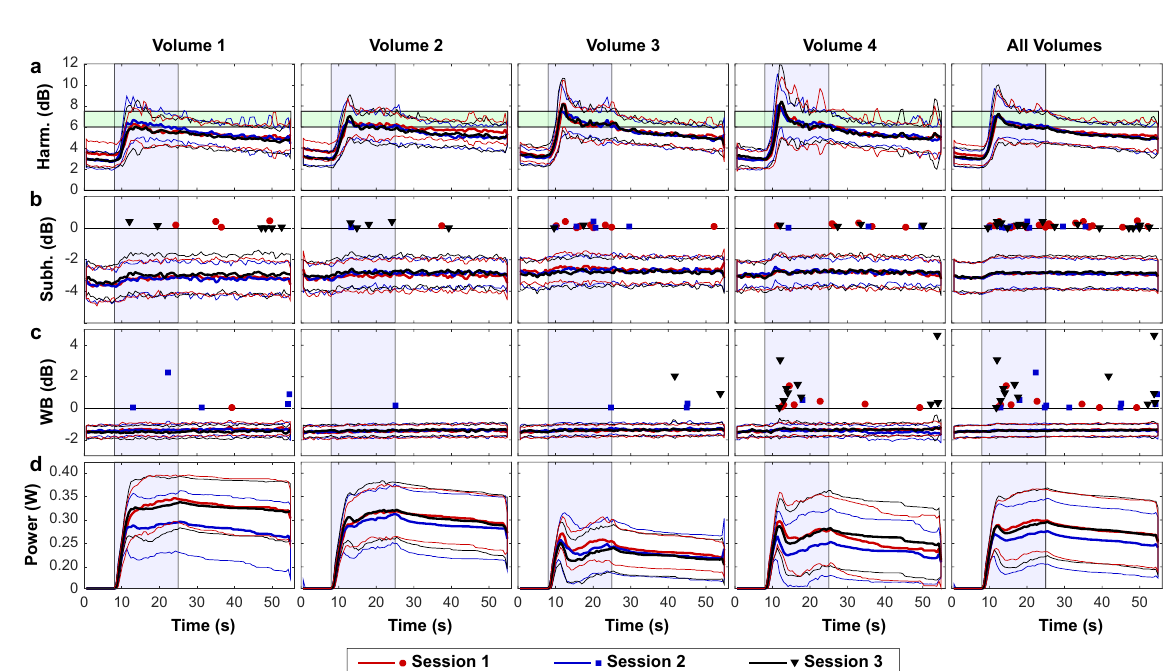
Figure 3. Mean acoustic emissions and acoustic power vs. time for all animals for the four volumetric sonications. ( b ) Harmonic emissions were the basis to control the power level at each target to achieve a pre- determined level between 6–7.5 dB above the noise floor. The controller began 8 seconds after the start of the sonication to allow time for the microbubbles to reach the brain; it was not allowed to increase the power after 25 seconds to avoid increasing the power as the microbubbles were cleared from circulation. Overall, the levels achieved were similar for the four locations targeted, for the three sessions, and for the different animals in the drug distribution study. Some overshoot was evident, particularly in locations 3 and 4. ( c ) Subharmonic emissions, plotted here in dB relative to the threshold used to trigger a reduction in acoustic power, were not reliably detected. The triggers that occurred are noted by the filled symbols and generally were only occurred at an amplitude slightly above this threshold. ( d ) Broadband emission, again plotted here in dB relative to the threshold that triggered a reduction in power, rarely occurred. When it did, its magnitude varied, and it was more likely in location four during the control period. ( e ) The acoustic power varied substantially from sonication to sonication and among the different sessions. However, its trajectory over time was similar for the different sessions. Location 3 consistently required a lower power level. (Thick lines: mean values; thin lines/ shaded areas: ± 1 standard